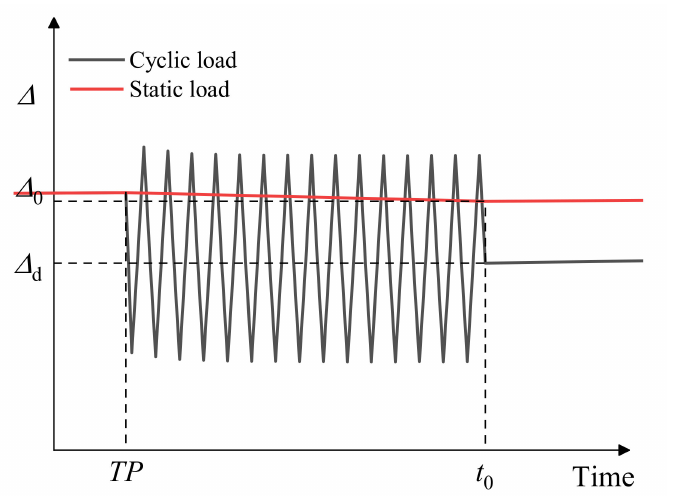
Figure 12. Calculation parameters diagram of cyclic load effect coefficient ( η ).